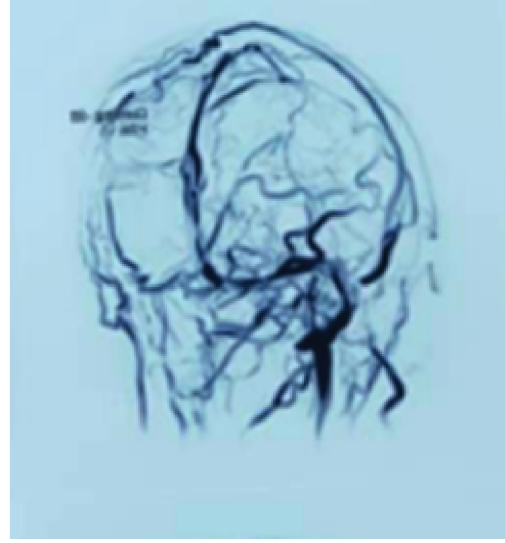
Figure 3: Brain MRV showing absence of right transverse